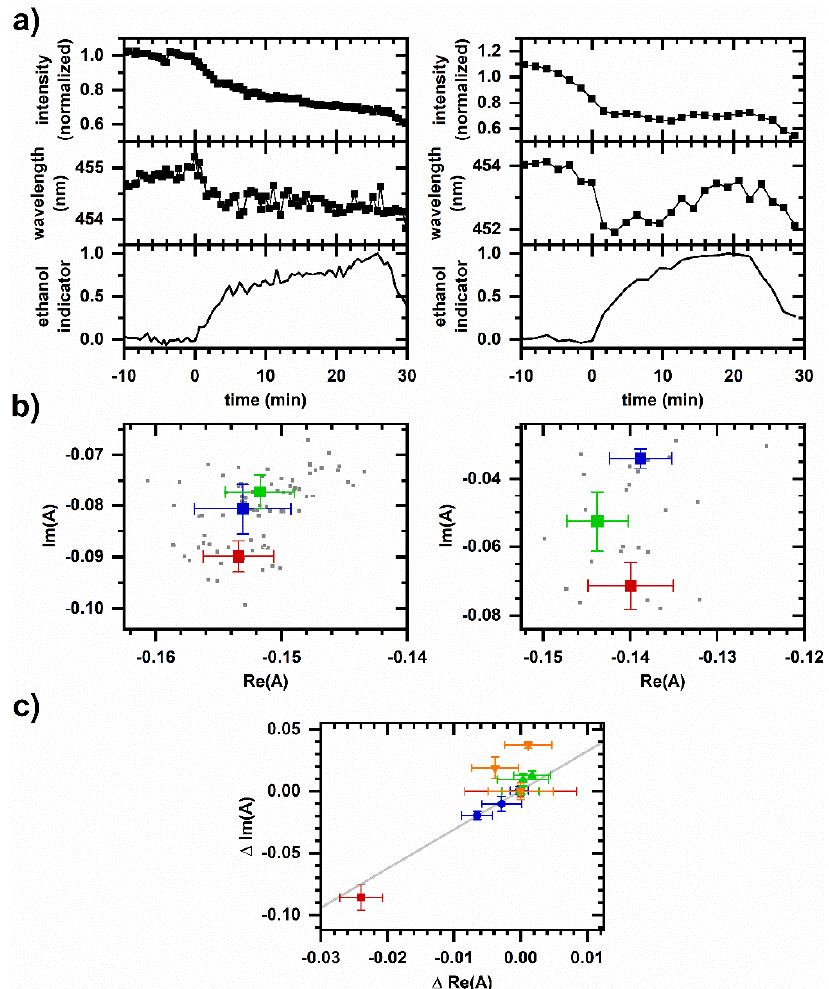
Figure 6. Cellular autofluorescence response to ethanol under pressurized conditions. Left column , 5 vol% ethanol, 12 MPa. Right column , 5 vol% ethanol, 30 MPa. Representative responses are shown; behavior is reproduced on N independently prepared samples, N = 3 at each pressure. ( a ) Autofluorescence intensity and average emission wavelength versus time. Spectrally integrated autofluorescence intensity is normalized to the intensity averaged over 10 min prior to ethanol introduction. Autofluorescence wavelength is calculated as an intensity-weighted average emission wavelength. Time is shifted so that ethanol is introduced to the sample at t = 0 min. 1 µM rhodamine is added to the reservoir as an ethanol indicator; shown is the integrated emission intensity for pixels 675–725 (572–585 nm wavelength) scaled to be between 0 and 1. ( b ) Phasor plots. Small symbols are phasors calculated from individual measurements. Large symbols are average and standard deviations of phasor values. Color corresponds to time intervals over which phasor values are averaged: red—10 min prior to ethanol introduction; blue—First 10 min after ethanol introduction; green—Second 10 min after ethanol introduction. Intensity, average emission wavelength, and phasor are calculated from a measured spectrum using the first 400 pixels (400–500 nm wavelength). ( c ) Comparison of phasor plots for ethanol-induced response data. Phasor values are shifted so that the initial phasor is at the origin. The datasets are red/square—ambient pressure, Figure 5c, left; blue/circle—Ambient pressure in perfusion system, Figure 5c, right; green/upright triangle—Response at 12 MPa, Figure 6b, left; and orange/inverted triangle—Response at 30 MPa, Figure 6b, right. Gray line is a linear least-squares fit to ambient pressure, microperfusion data (blue circles) only.